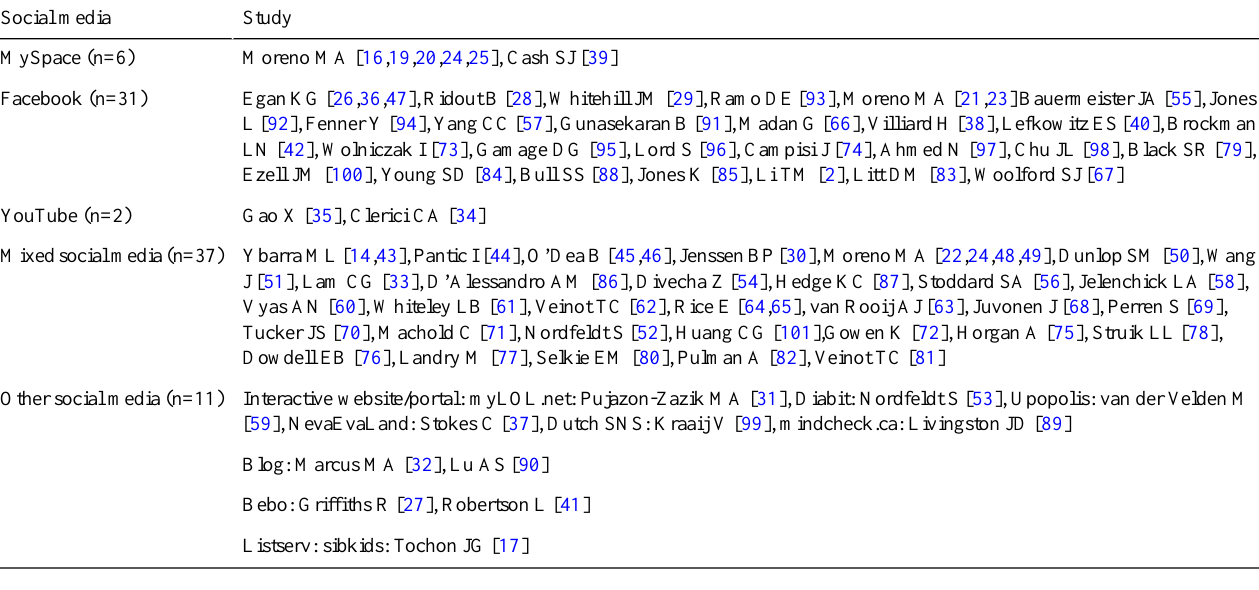
Table 5. Types of social media used in the studies included in the systematic